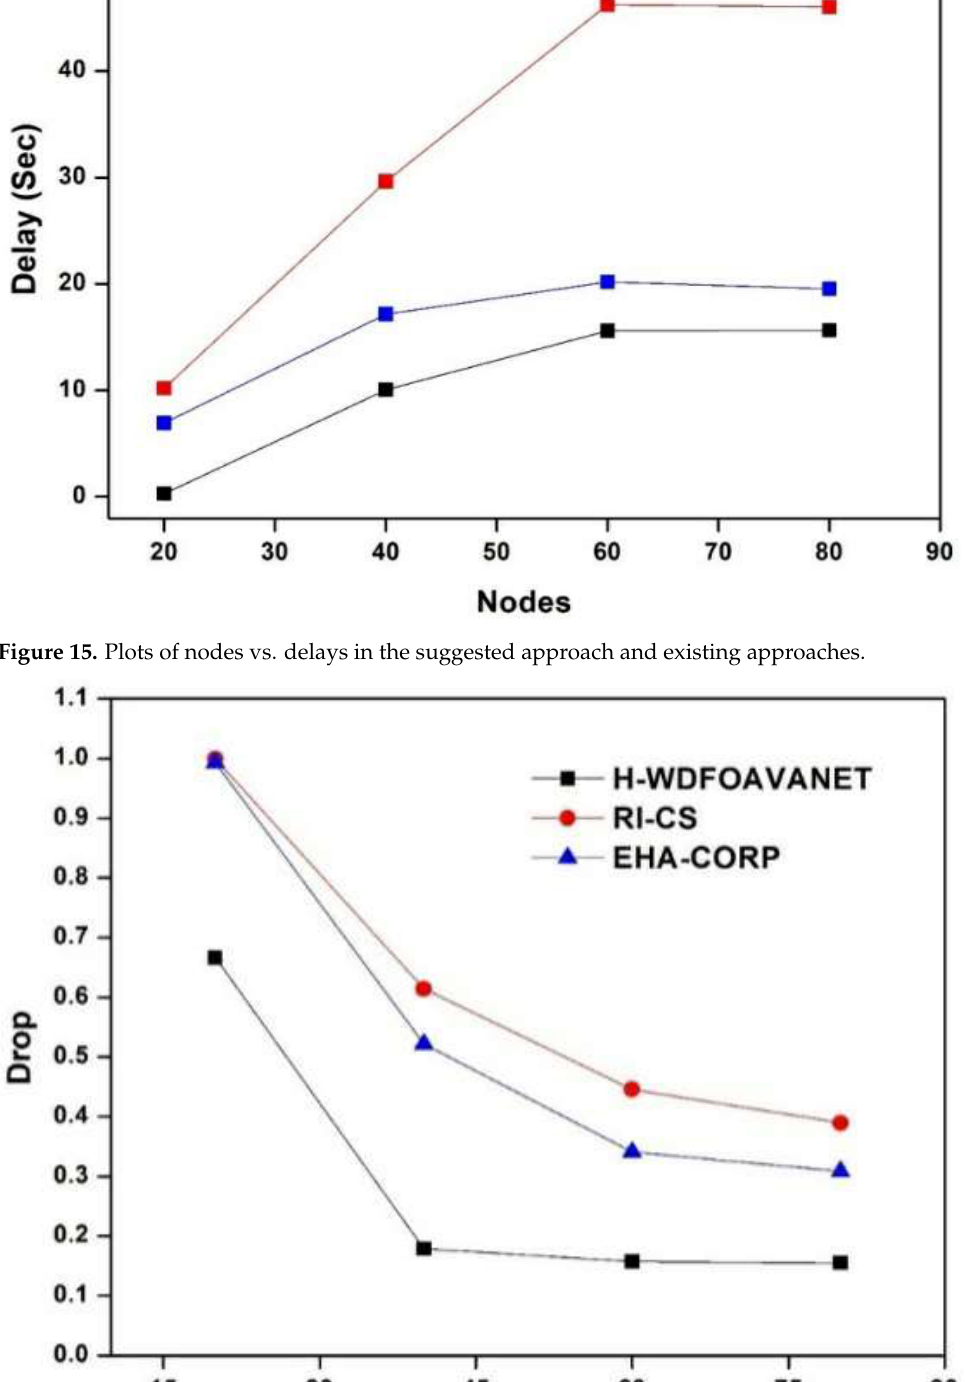
Figure 16. Plots of nodes vs. drop in the suggested approach and existing approaches.